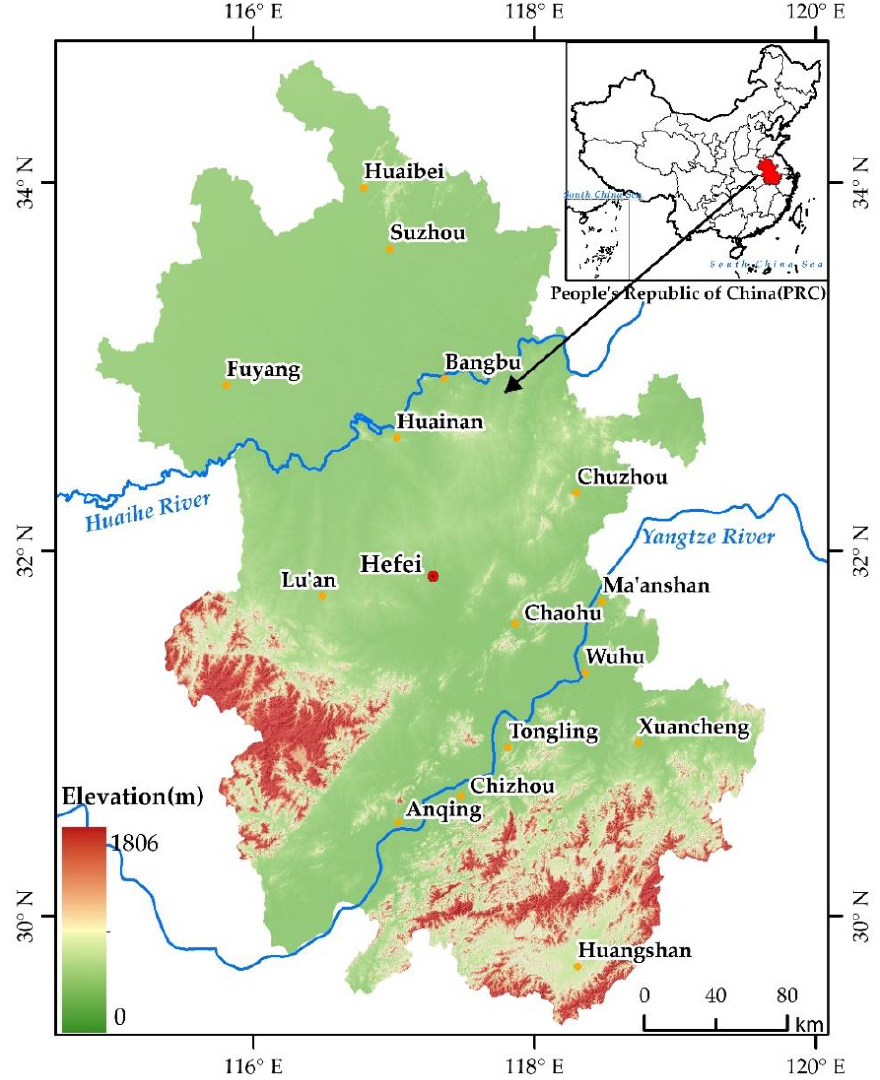
Figure 1. Location of the study area.